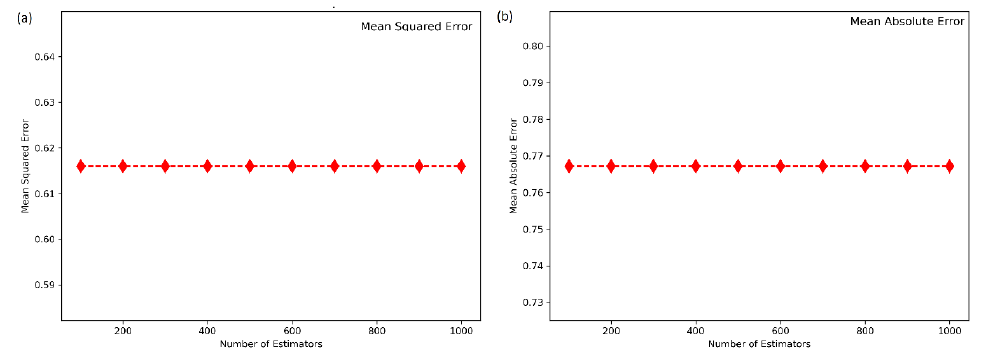
Figure 4. Effect of the number of estimators on AdaBoost regression measured using ( a ) MSE and ( b ) MAE for modelling Zn (g/L).